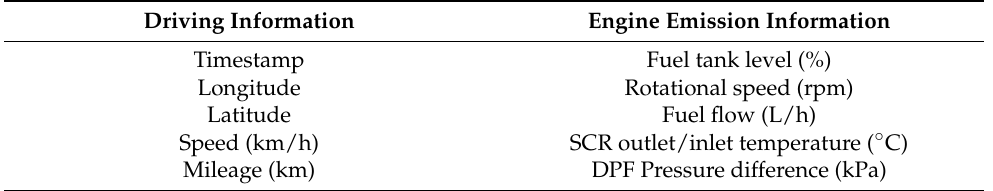
Table 1. Parameters collected from the data